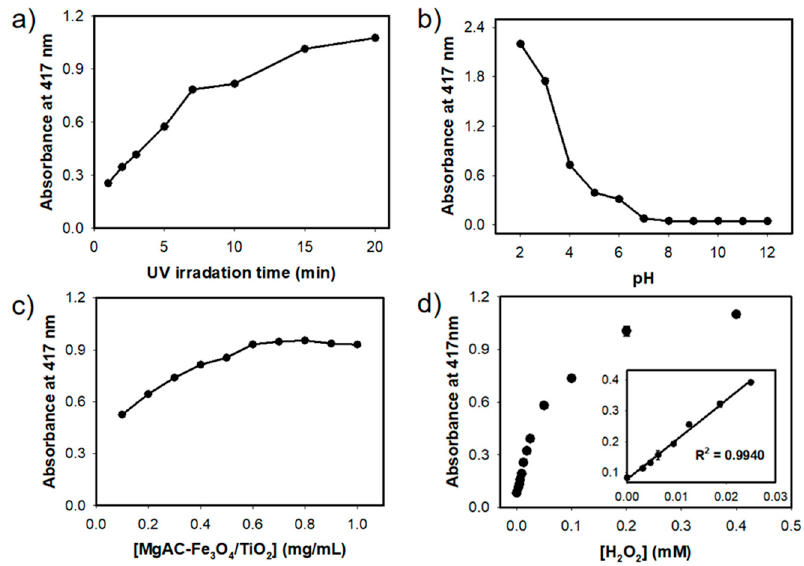
Figure 4. Effects of ( a ) duration of UV-light irradiation, ( b ) buffer pH, and ( c ) employed concentration of MgAC-Fe 3 O 4 /TiO 2 on the peroxidase activity. ( d ) Dose-response curve and calibration plot (inset) for H 2 O 2 determination using UV-light-driven MgAC-Fe 3 O 4 /TiO 2 -based system. In contrast with natural peroxidase, MgAC-Fe 3 O 4 /TiO 2 are expected to be stable. To